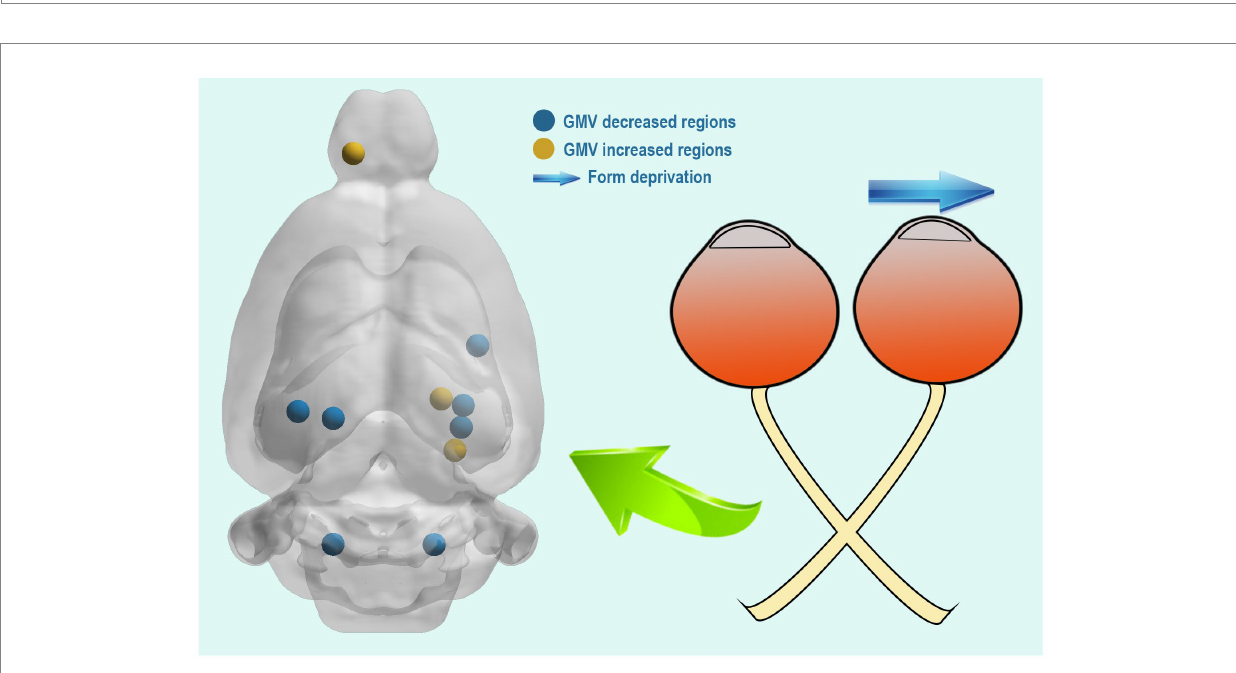
FIGURE 5 Compared with the NC group, the FDM group had altered brain regions after 4 weeks of right eye form deprivation. NC, normal control; FDM, form- deprivation myopia.